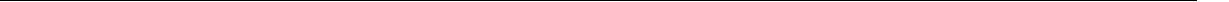
Fig. 1 Design and characterization of SynaptoZip. a Cartoon depicting the reporter system; box diagrams illustrate SZ moieties. S1, S2: spacer sequences; Zip: Acid-p1. b WB of transfected (GZ, SZ) and non-transfected (Ctrl) Hela cells, detection with anti-VAMP2, anti-Myc epitope tag, anti-GFP antibodies, and with SB-Alexa647 (see also Supplementary Fig. 1a). c Analysis of Zip-Bond binding in live Hela cells (the red line is the logistic fi tting, adj. R 2 = 0.98, K = 5.09 nM; N = 38, N = 65, N = 45, N = 80, N = 59, N = 39, N = 48, N = 36; mean ± s.e.m.). d SB uptake in a mixture of d 0.1nM 1nM 2nM 3nM 5nM 10nM 30nM 100nM transfected and non-transfected Hela cells (green, eGFP; red, SB and DIC image; SB 5 nM, 1 h incubation). e Histograms of SB fl uorescence and their cumulative representation (Inset; N = 320, non-expressing cells; N = 636, GZ-expressing cells; SB expr = 0.284 ± 0.089, SB non-expr = 0.063 ± 0.014, mean ± SD; p < 0.01, KS test). f Analysis of the fate of internalized SB in SZ-expressing Hela cells. Left, internalized SB-Alexa647 was not displaced by excess of SB-Alexa488 (time-lapse imaging, N = 6; mean ± s.e.m.). Right, vesicular SB remains up to 48 h from extracellular washout ( N 5min = 71, N = 60, N = 47, N = 60, N = 53, N = 73, N = 42, N = 39, N = 37, N = 50, N = 47; mean ± s.e.m.). g Hela cells expressing 0.5h 1h 1.5h 2.5h 3.5h 5.5h 6.5h 21h 24h 48h non- fl uorescent SZ were incubated sequentially with SB-Alexa488, SB-Alexa647, SB-Alexa568. h Cumulative histograms of cell fl uorescence from N = 92 cells as in g , illustrating the labeling similarity among the epochs ( p ≥ 0.26; KS test). Scale bars, 10 μ m, 1 μ m inset ( d ) and 10 μ m ( g